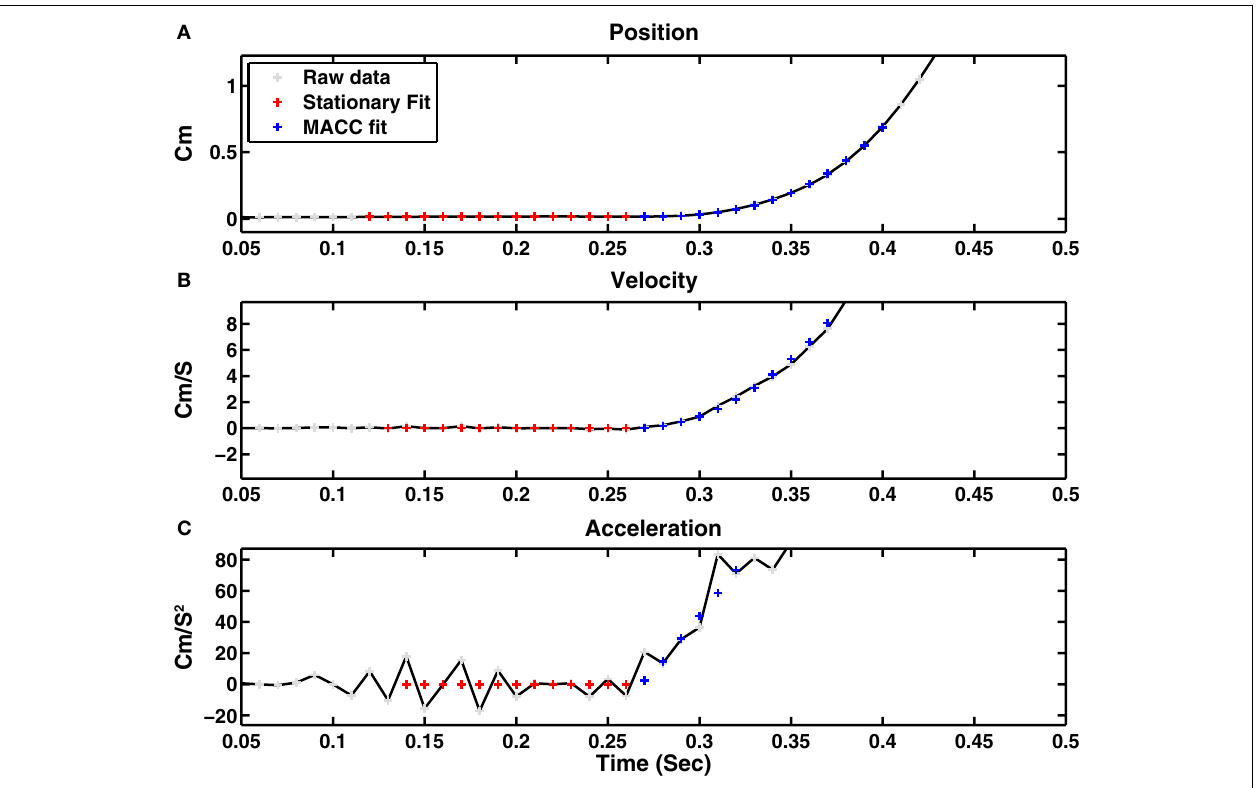
FIGURE 4 | Example of a recorded reaching movement with onset detection according to MACC and to the 5% velocity threshold. (A) Recorded position along with onset detection method and the best MACC fi t model. (B) Velocity. (C) Acceleration. The MACC defi ned onset point is 50 ms earlier than the onset point as determined by the 5% velocity threshold. Onset detections by the experts for this example ranged from 0.26 to 0.32 s, while the MACC onset detection was 0.26 s.